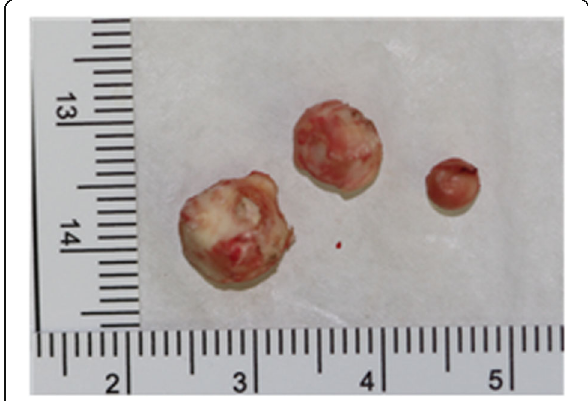
Fig. 2 Excised calcified masses shows round- to oval-shaped and whitish-yellow-colored bodies of varying